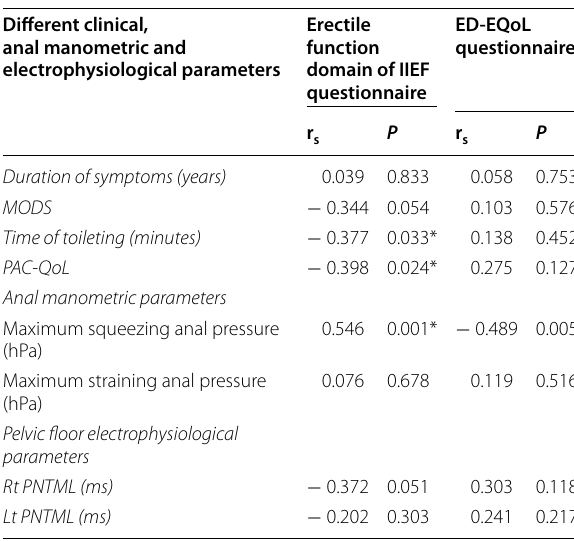
Table 5 The results of logistic regression analysis predicting the development of erectile dysfunction from some selected assessed parameters among obstructed defecation patients (n